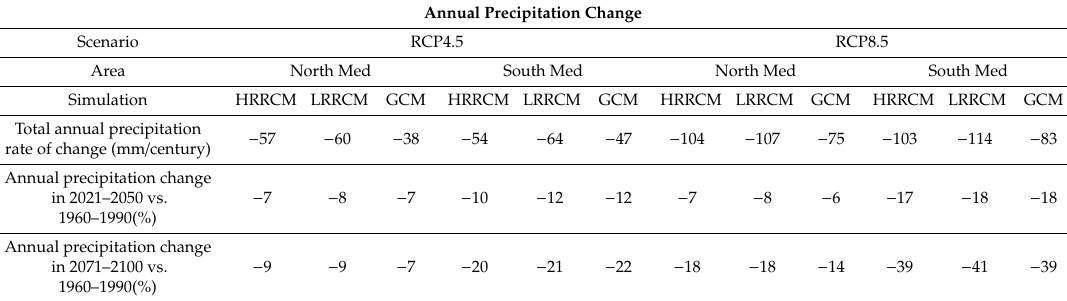
and long-term (2021–2050 and 2071–2100, respectively) with respect to reference period (1961–1990).